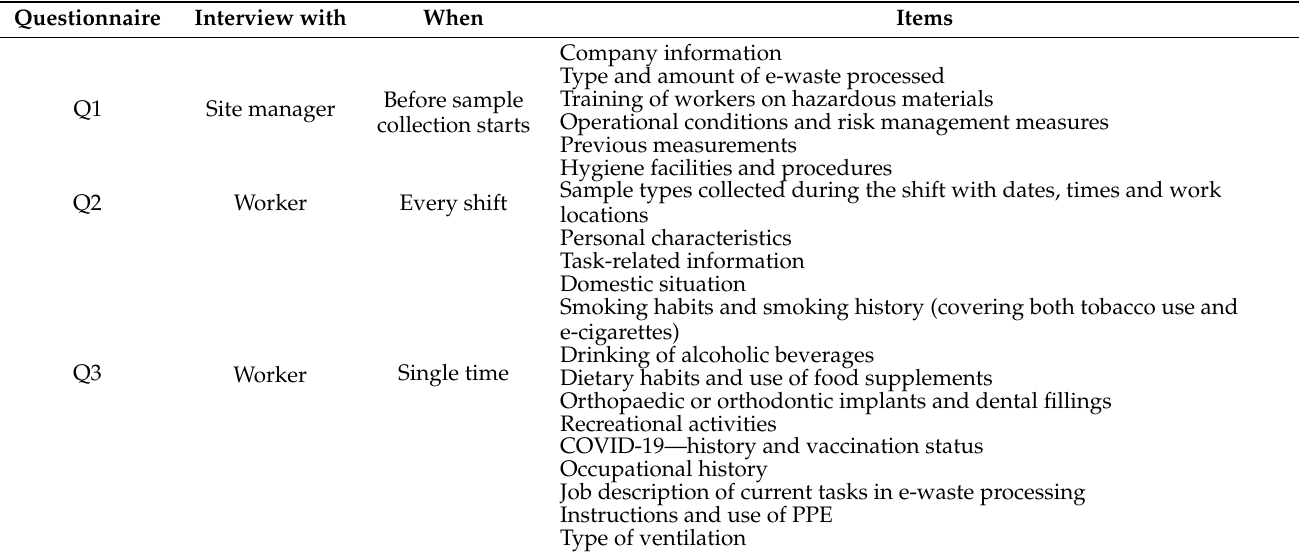
Table 4. Questionnaires and questionnaire items for determination of contextual information.